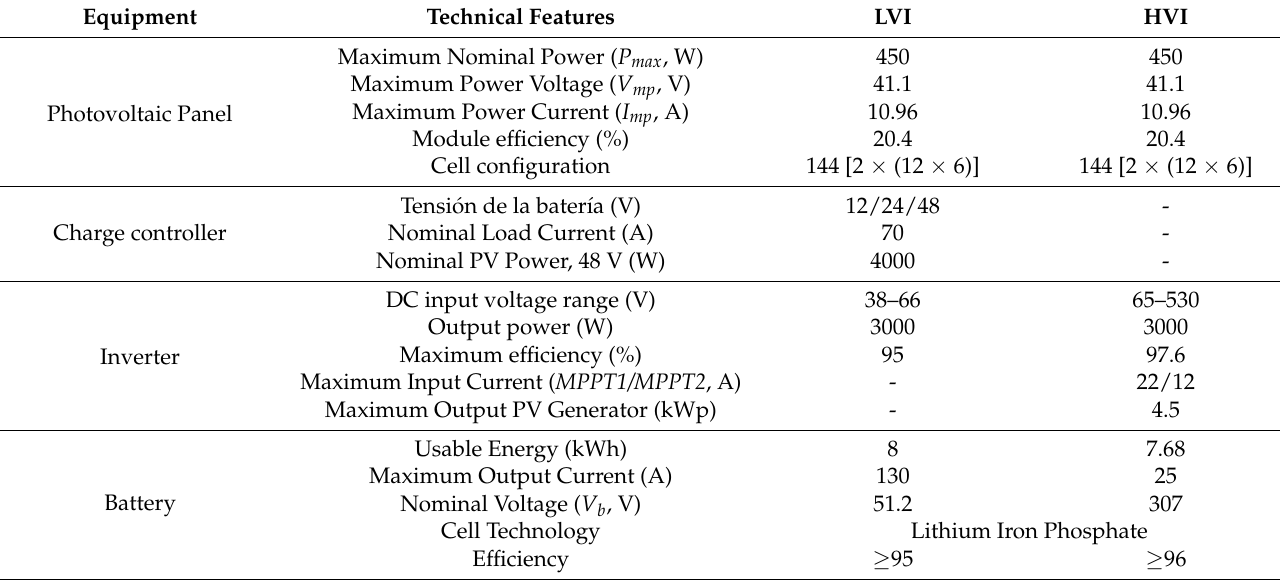
Table 2. Characterization of the prototype.